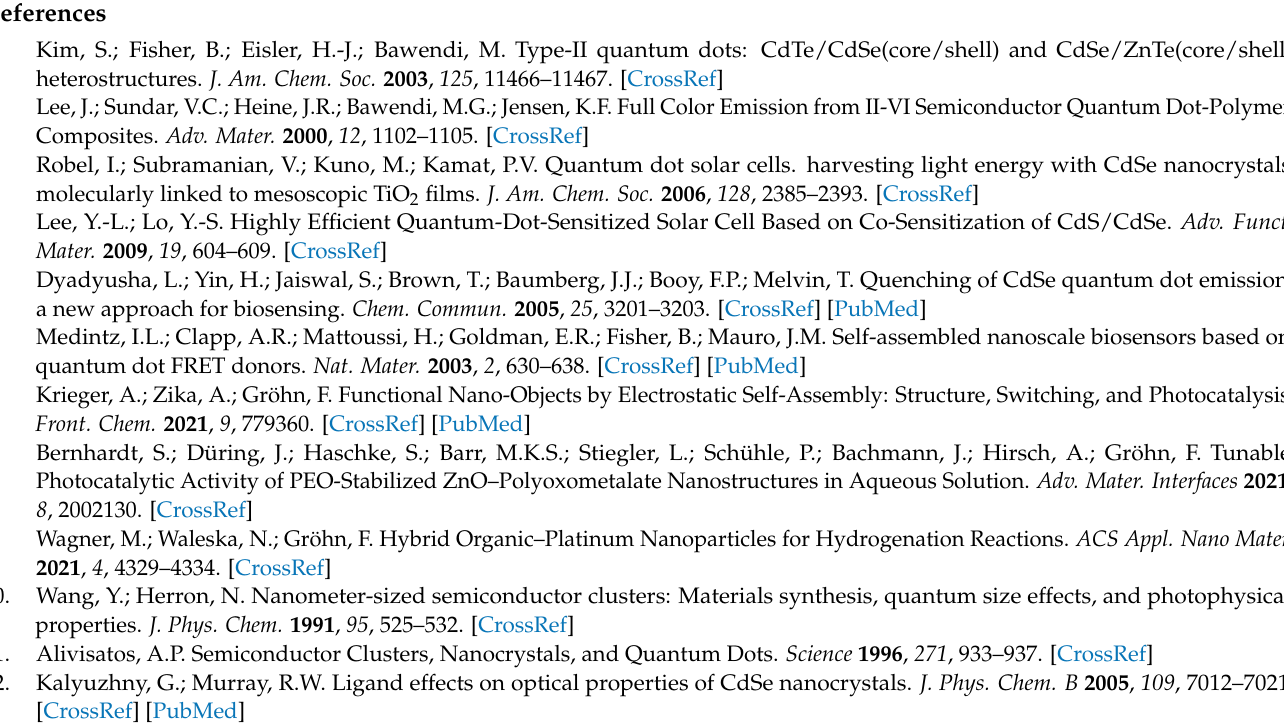
Figure S2: TEM images of CdS–ZnS core–shell nanoparticles, Figure S3: Absorption spectrum of crocin and time dependent photo-bleaching reaction of crocin with CdS–Zn x Mn 1 − x S-TAPP aggregates including references without TAPP, Figure S4. Absorption spectra of crocin with CdS-Core-shell zinc manganese mixtures, Figure S5: Absorption spectra of TAPP binding to a CdS particle in dependence of TAPP